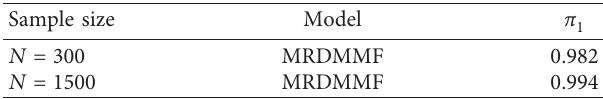
Table 4: Estimated values of the mixture weight of the simulation study (second scenario).